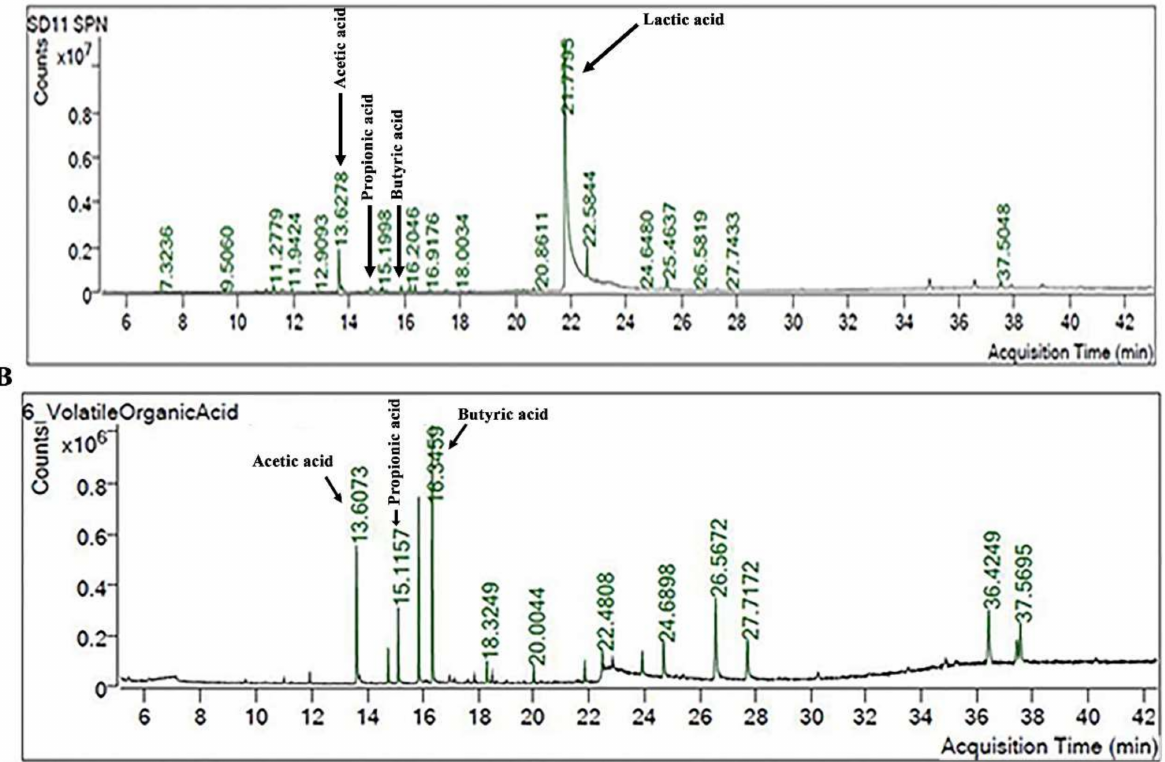
Figure 1. The GC-MS profile of SCFAs produced by L. rhamnosus SD11 before ( A ) and after extraction ( B ). The butyrate level and the propionate level of each strain were evaluated with the calibration curve. This study focused on butyrate production; therefore, only the butyrate production of the strains tested was